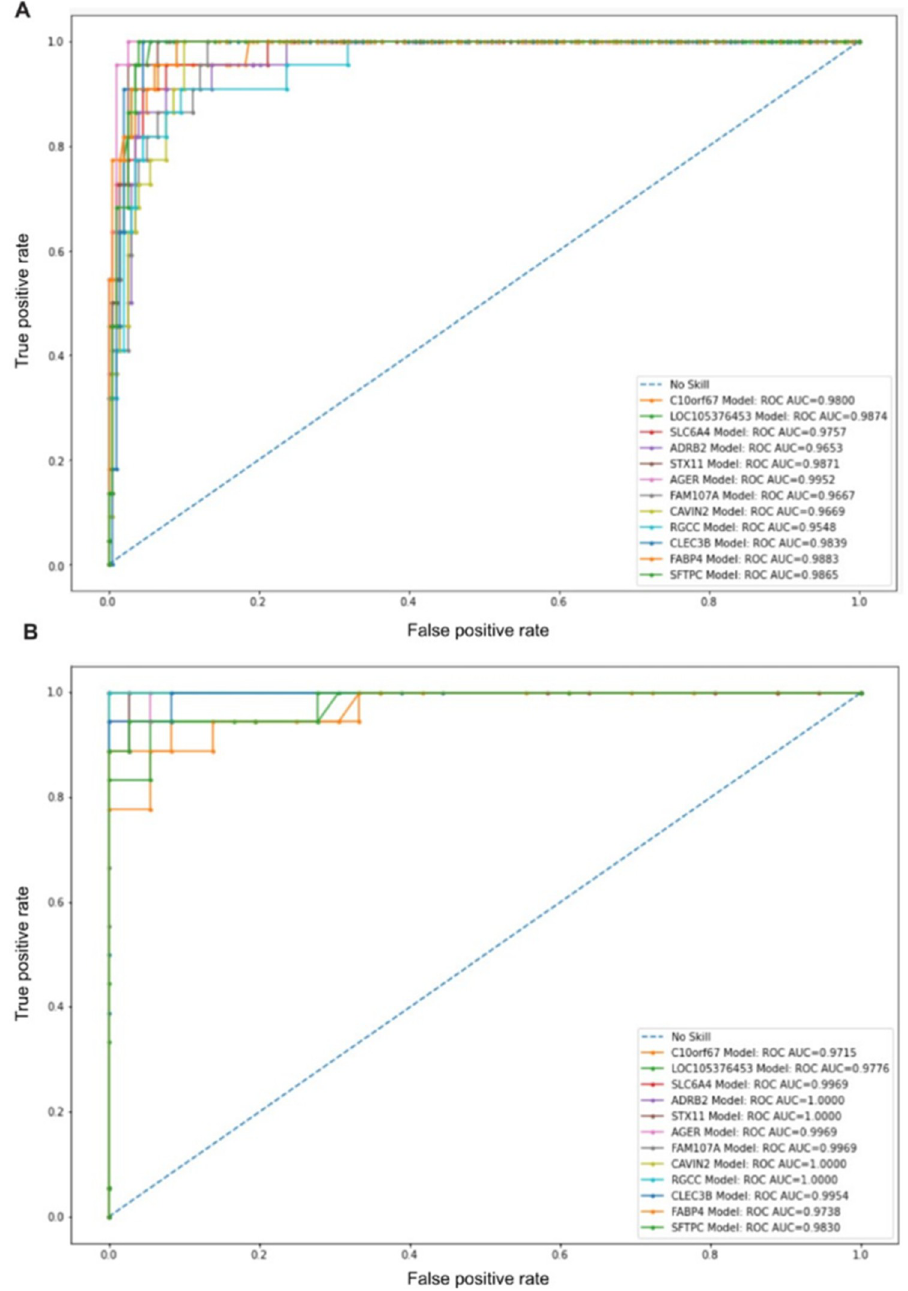
Fig 15. ROC curve analysis demonstrates the discriminating potential for the identified biomarkers. X-axis is the false positive rate (FPR). Y-axis indicates the true positive rate (TPR). Higher AUC suggests a higher discriminating potential for the gene. (A) The proposed model. (B) External